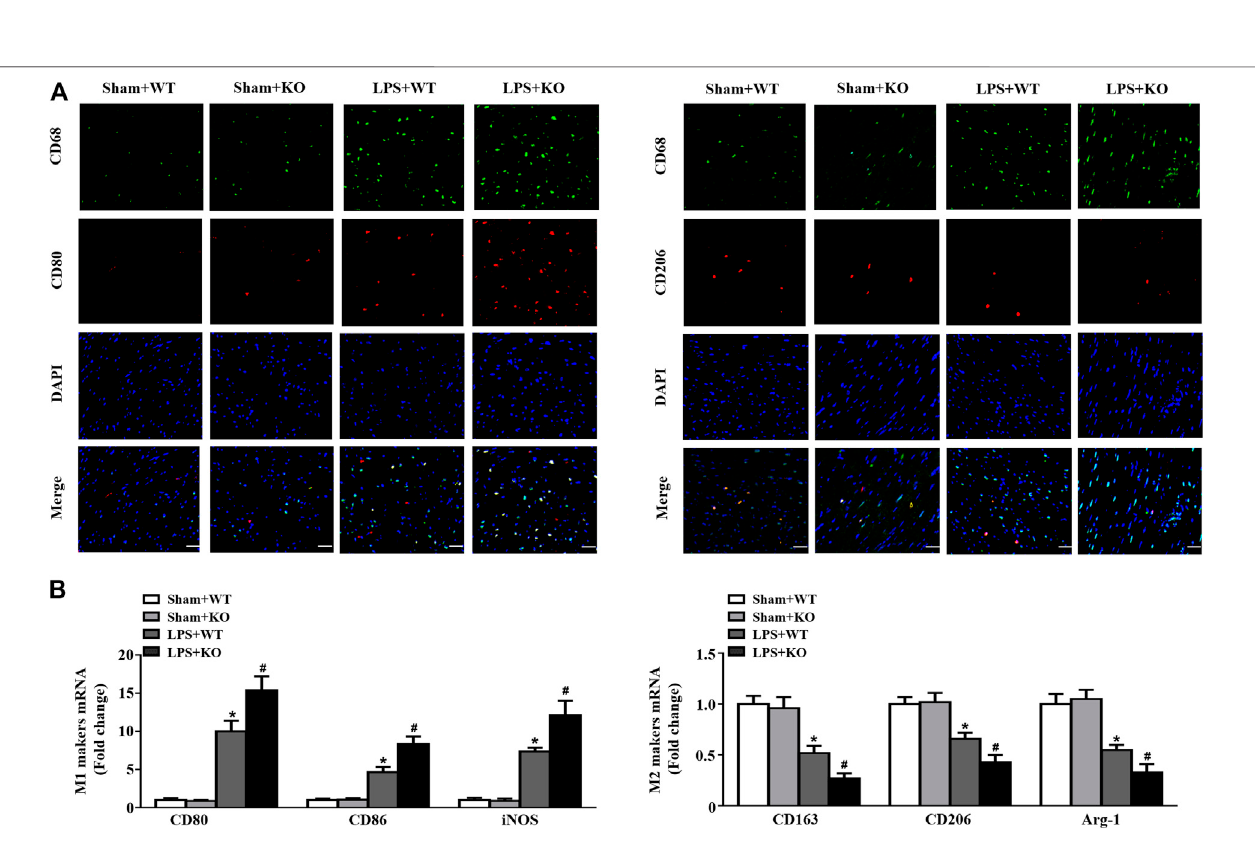
FIGURE5| Il12a deletionmediatesmacrophagepolarizationintheheart. (A) Immuno fl uorescence analysisofCD80andCD206intheheartsofeach group(n (cid:1) 4; scalebar,50 μ m) (B) RT-PCR analysisofCD80,CD86,iNOS, CD163,CD206andArg-1 mRNAexpression inheartsofeach group(n (cid:1) 4).* p < 0.05compared withthe sham + WT group; # p < 0.05 compared with the LPS + WT group.